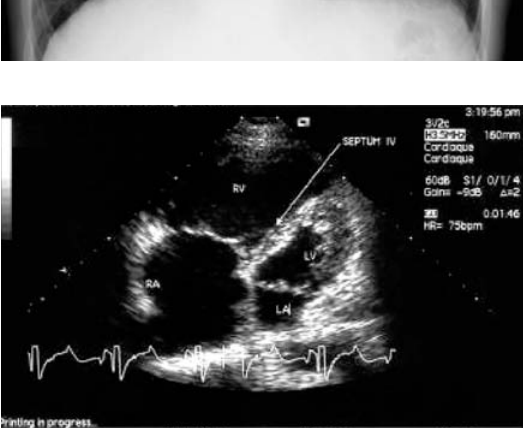
Figure 2 Chest radiograph in a patient with severe chronic thrombo- embolic pulmonary hypertension (mean PAP: 52 mm Hg) showing a dilatation of the central pul- monary arteries, a sudden reduction of the vessel calibres (right), a bulging of the middle left arch and a scarcity of peripheral vessels (“pruning”).